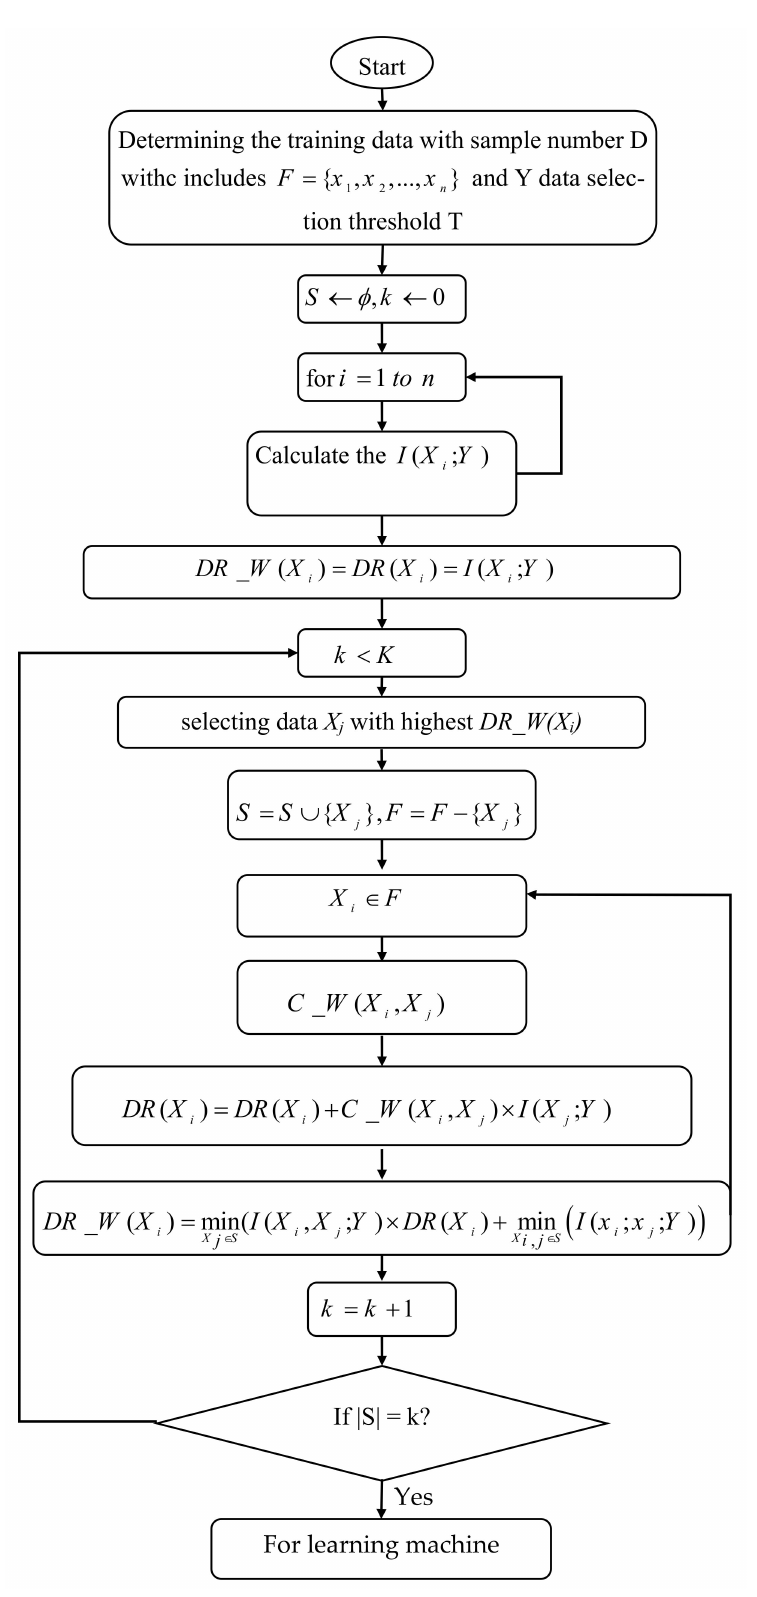
Figure 2. Flowchart of the proposed algorithm in data